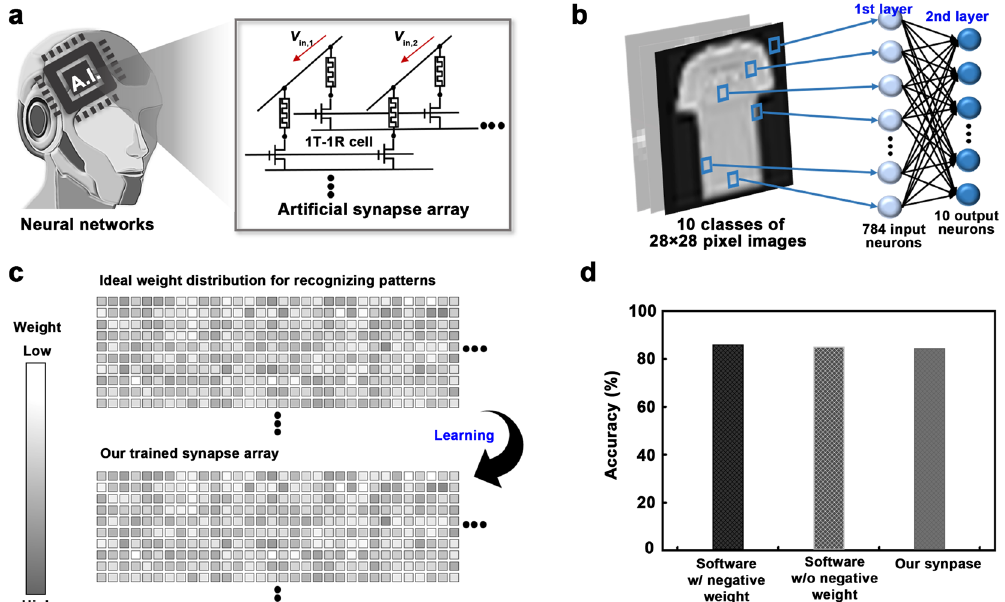
Fig. 4 Pattern recognition in neural networks based on the developed synapse array. a Schematics presenting the 1T – 1R structured crossbar array and its applications. b A fully connected one-layer neural network for the recognition of labeled fashion images. The input (784 neurons for input images with 28 × 28 pixels) and output (10 neurons for 10 classes of images) neurons were used. c Distributions of ideal synaptic weights for the accurate pattern recognition (top) and the weights of the trained synapse arrays after the learning process (bottom). d Recognition accuracy after training 10 epochs for an ideal software and the developed synapse-based neural